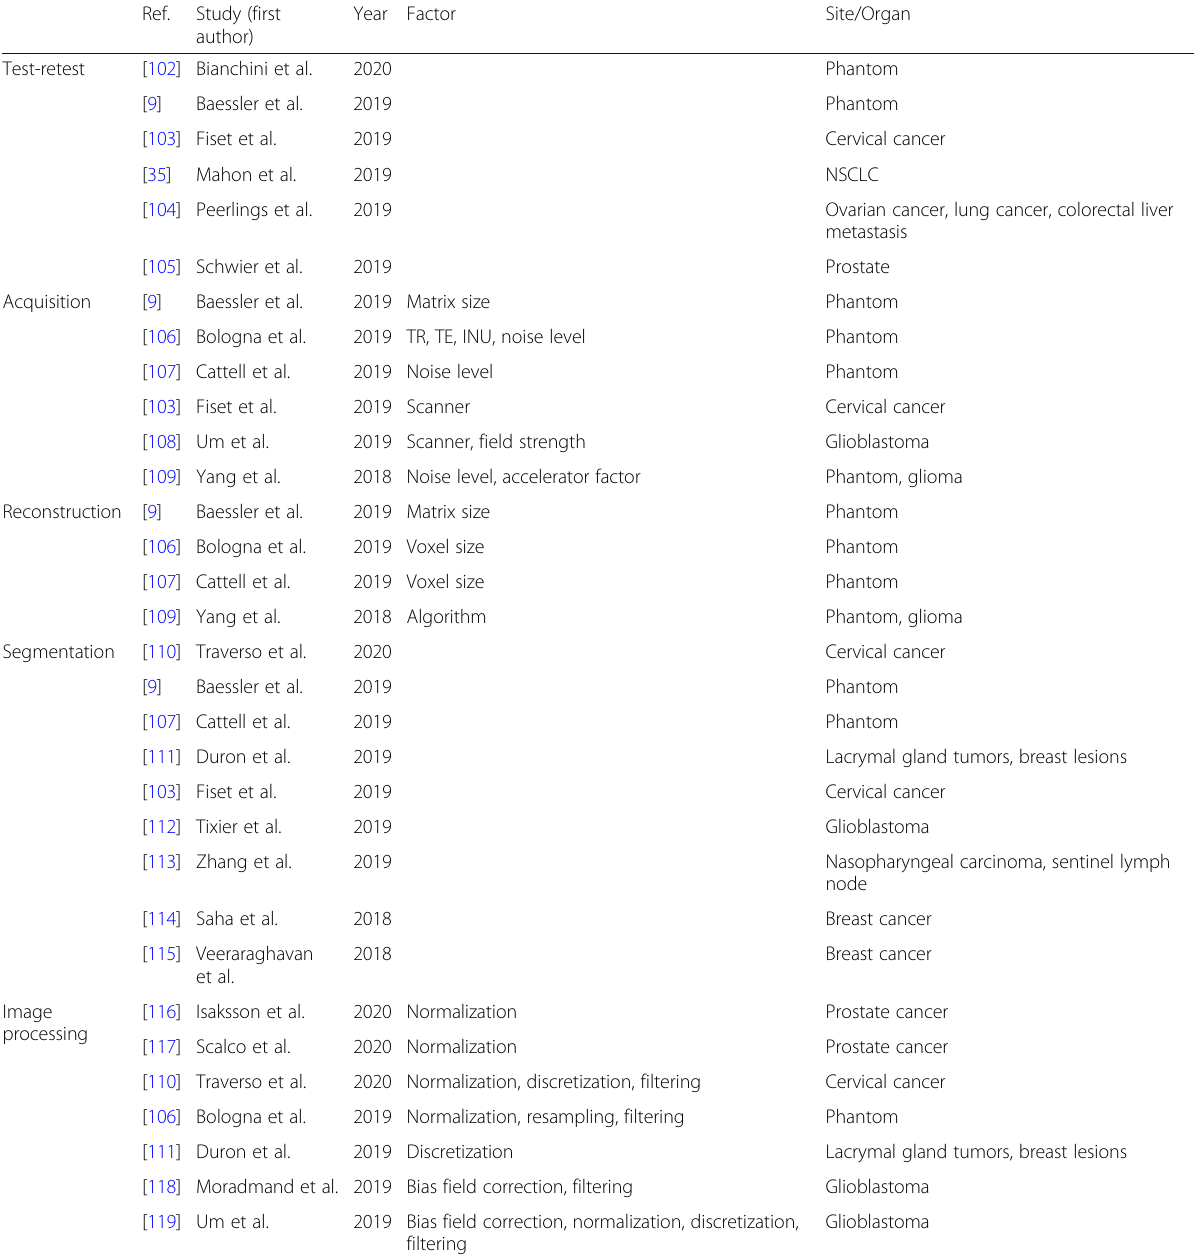
Table 3 Literature review for oncologic imaging or phantom studies with magnetic resonance imaging